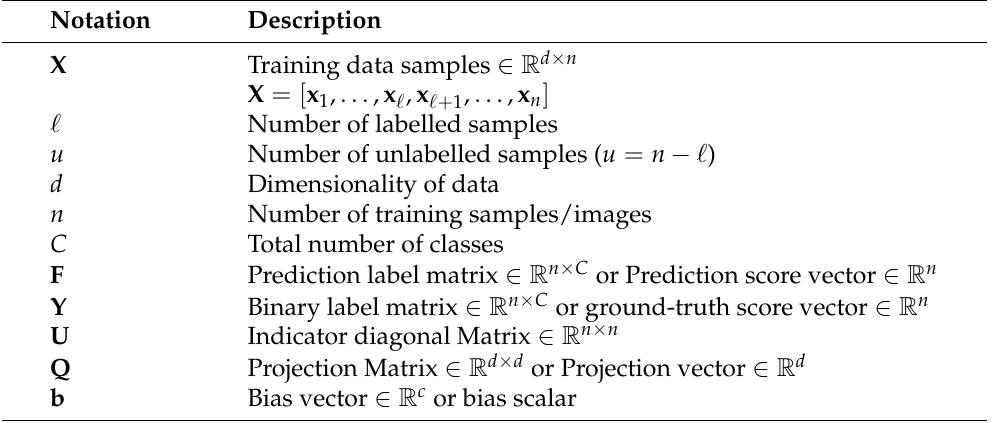
Table 1. The primary notations used in the